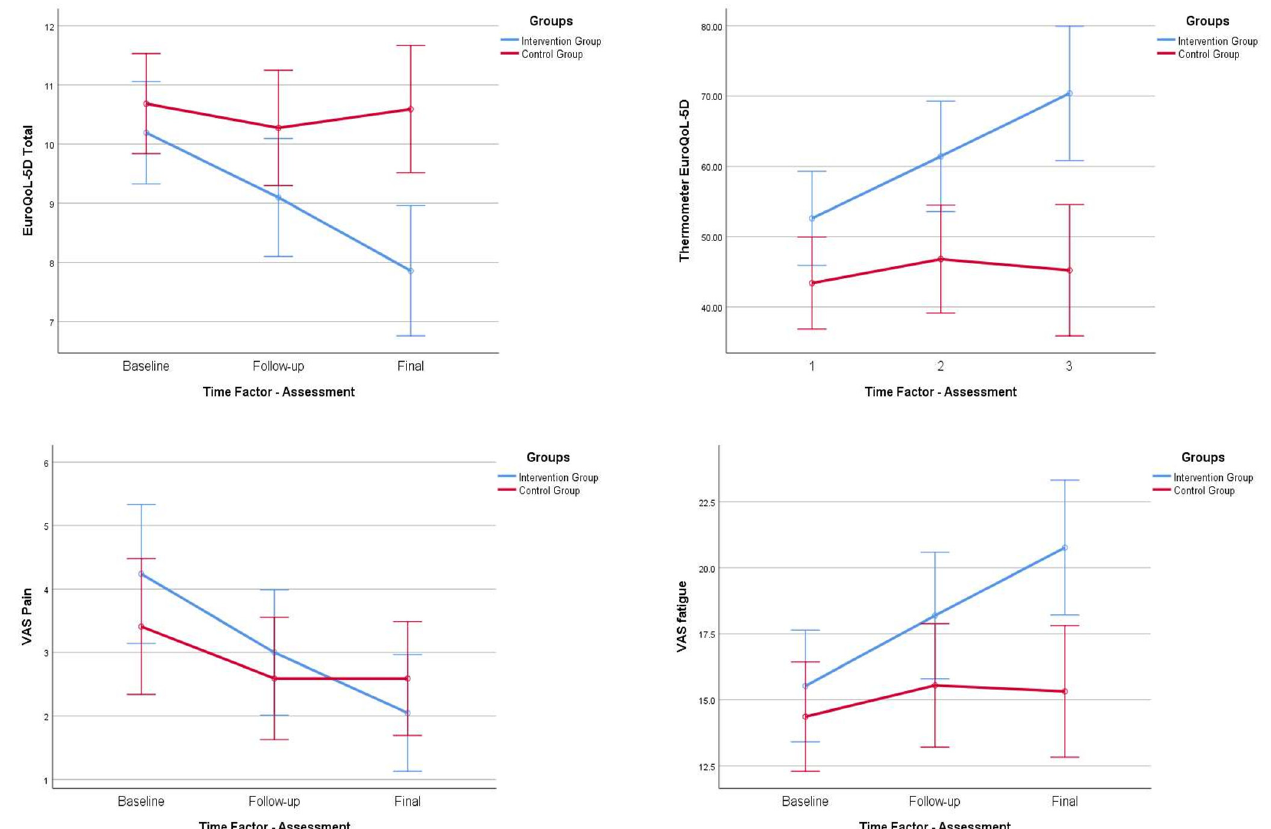
Figure 3. Within-group behavior and follow-up of score, EuroQoL 5D, VAS pain, and VAS fatigue scale. Comparisons between both groups. IG, intervention group; CG, control group; QoL, quality of life; VAS, visual analogic scale.